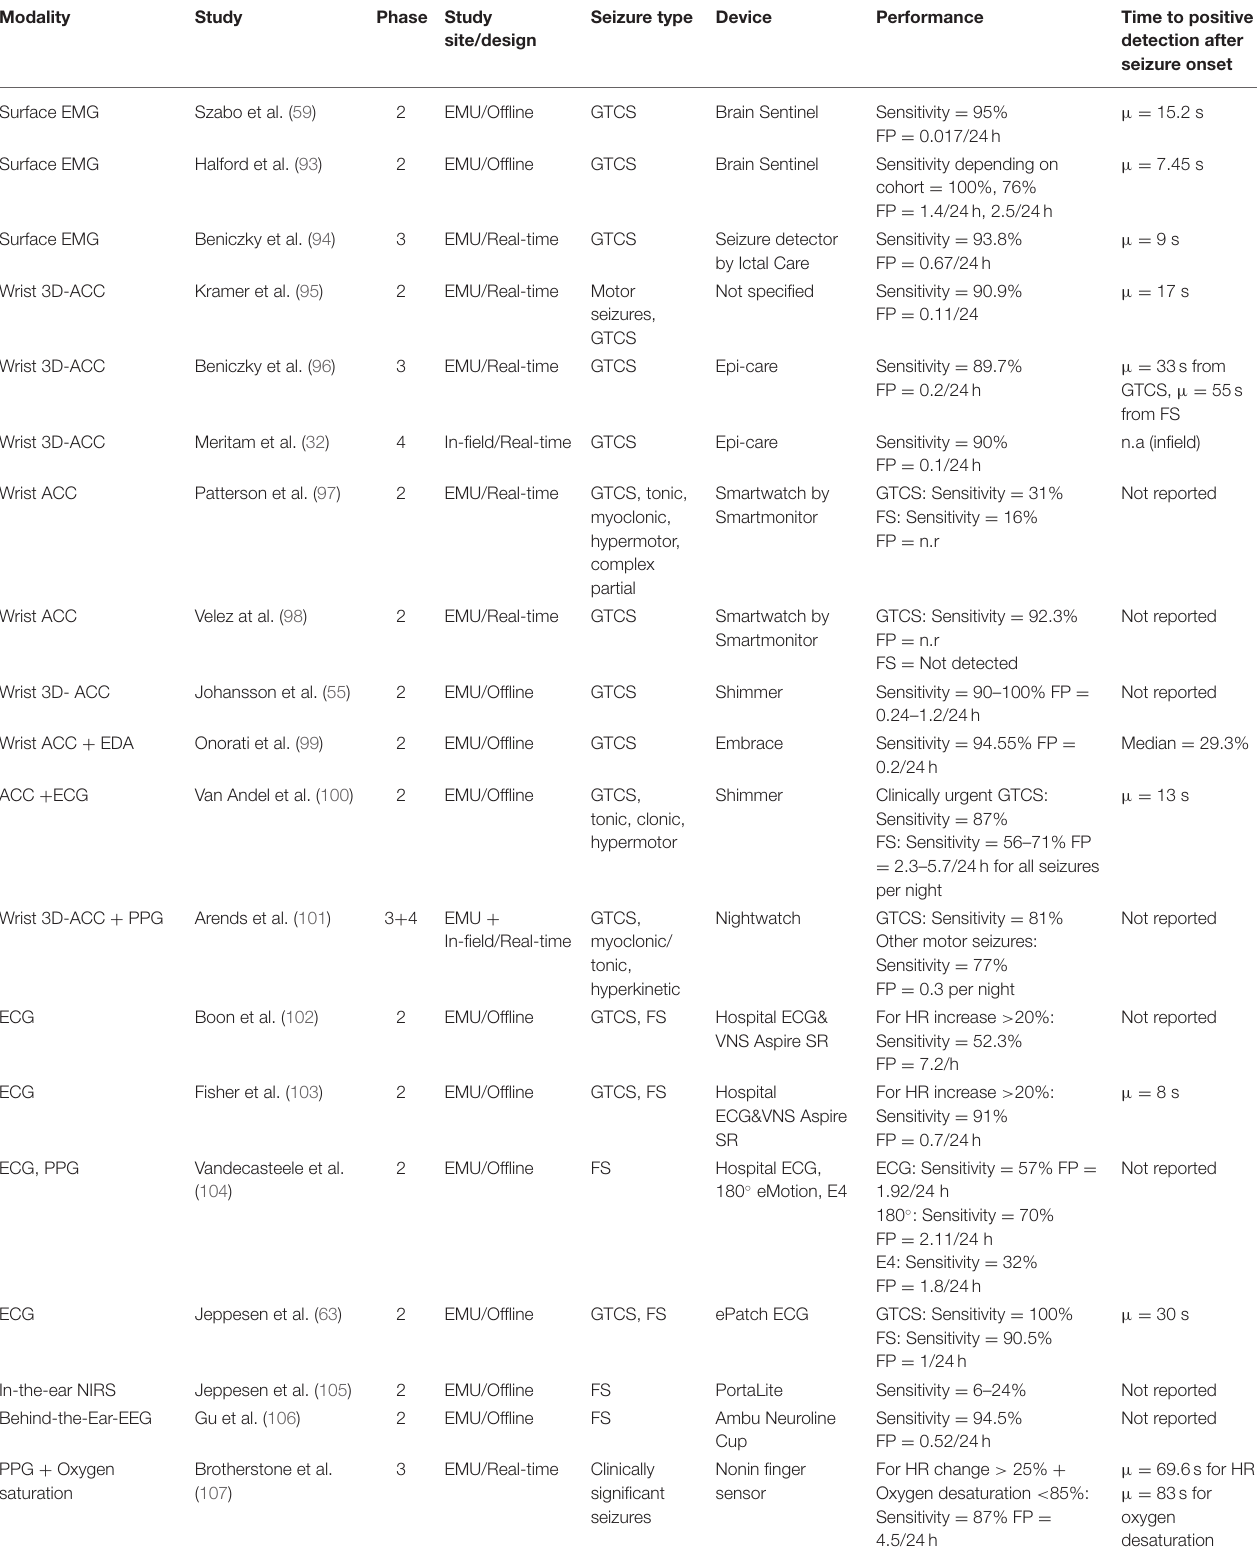
TABLE 1 | Outcomes of phase 2–4 prospective seizure detection algorithm reliability